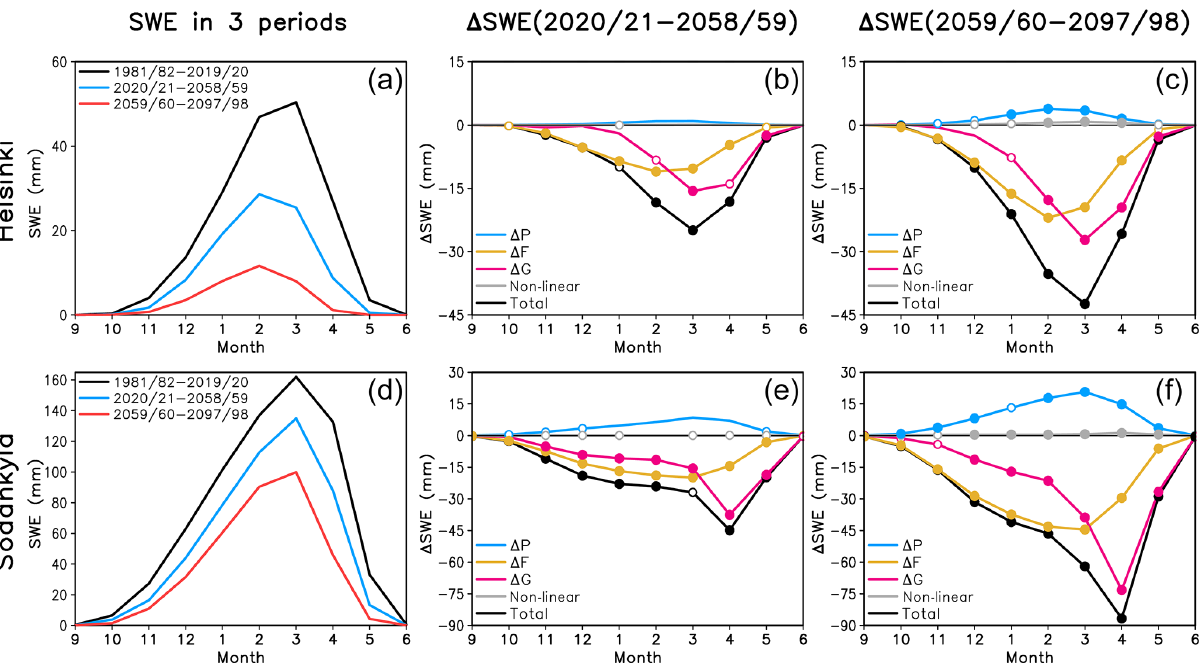
Figure 9. (a, d) Multi-RCM mean SWE in Helsinki and Sodankylä in the winters 1981/82–2019/20 (black), 2020/21–2058/59 (blue) and 2059/60–2097/98 (red). (b, e) Changes from 1981/82–2019/20 to 2020/21–2058/59 decomposed into the contributions of the four rhs terms in Eq. (2) (see the legend for line colours). Months in which all 17 (14–16 of the 17) simulations agree on the sign of the change are indicated with a closed (open) circle. (c, f) As (b, e) but for the changes from 1981/82–2019/20 to 2059/60–2097/98.